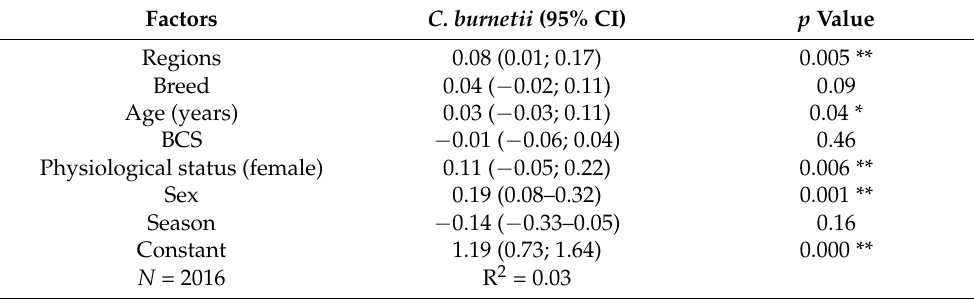
Table 4. Model analysis of with C. burnetii seropositivity among zebu cattle sampled from slaughter- house ( n = 2016) in the northern regions of Cameroon (Adamawa, North and Far